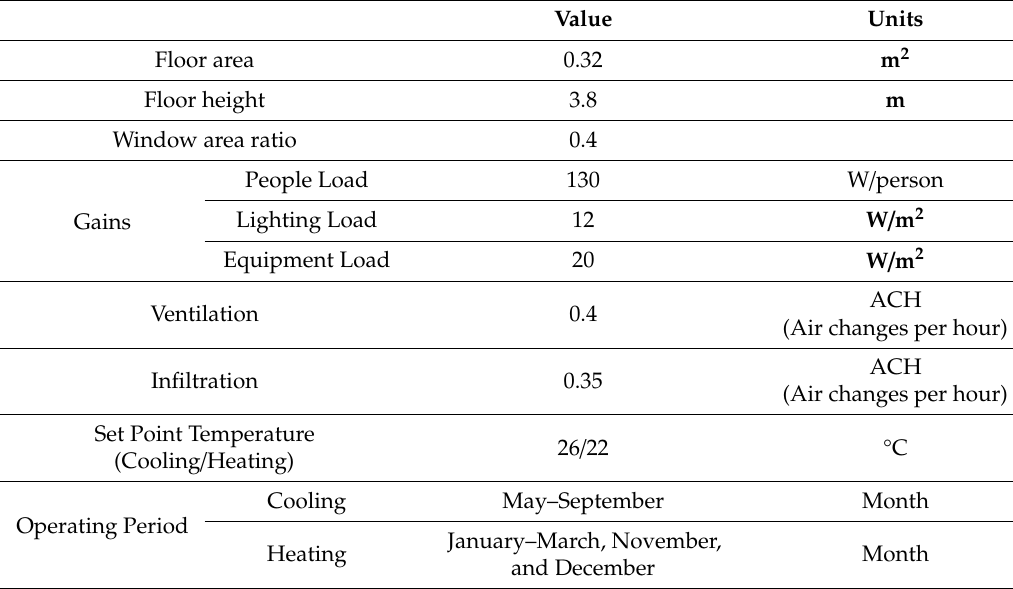
Table 3. Summary of the target building.